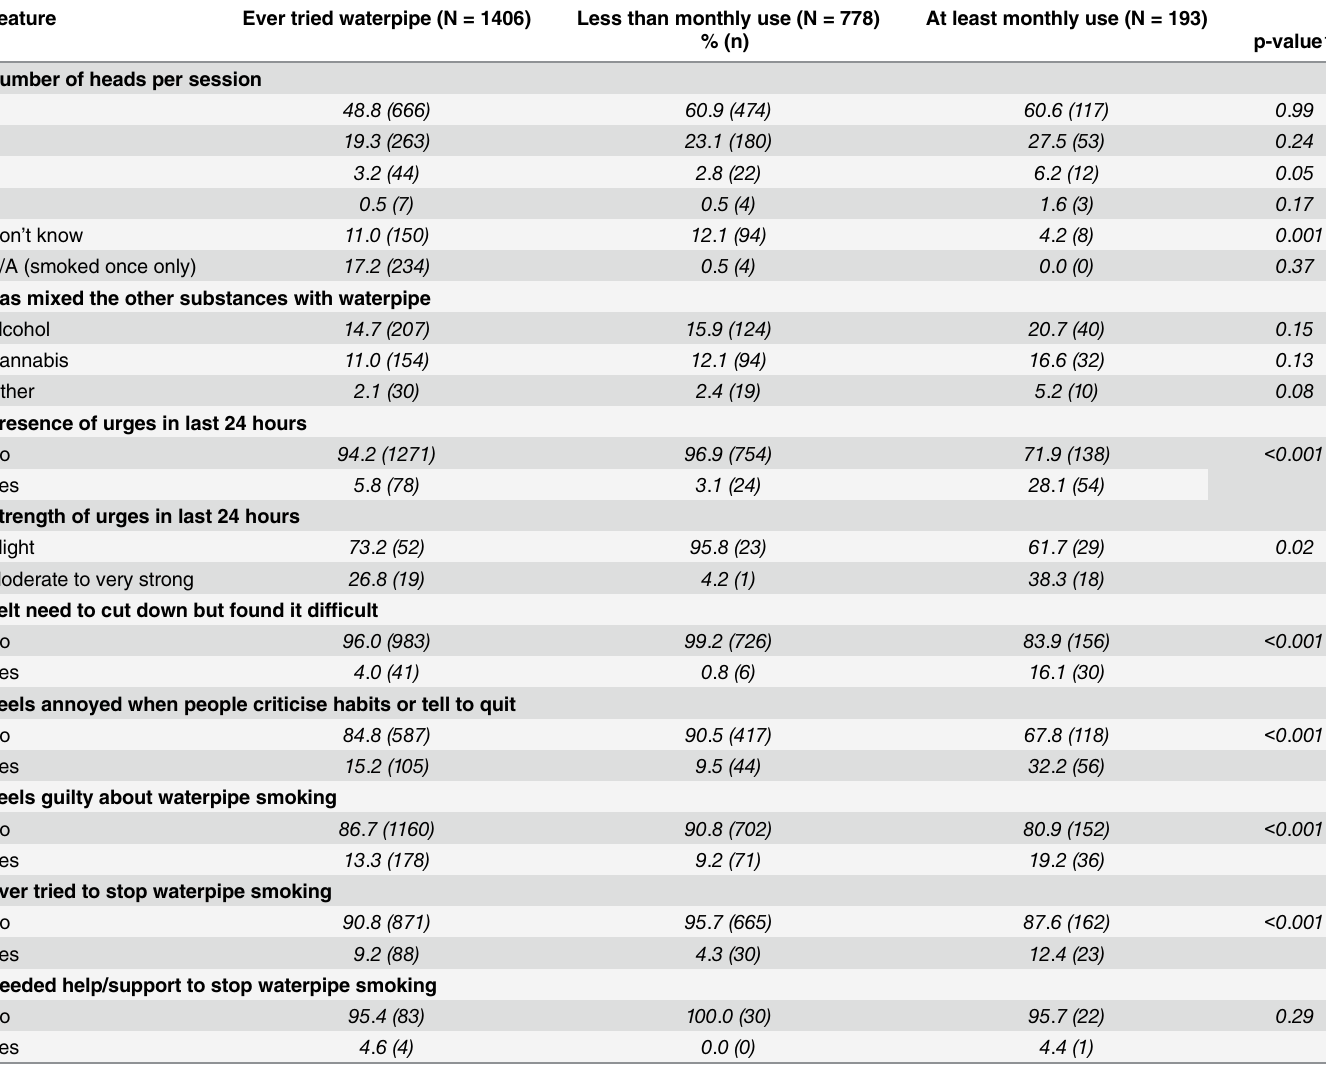
Table 5. Other features of respondents who had ever tried waterpipe tobacco, stratified by frequency of use.